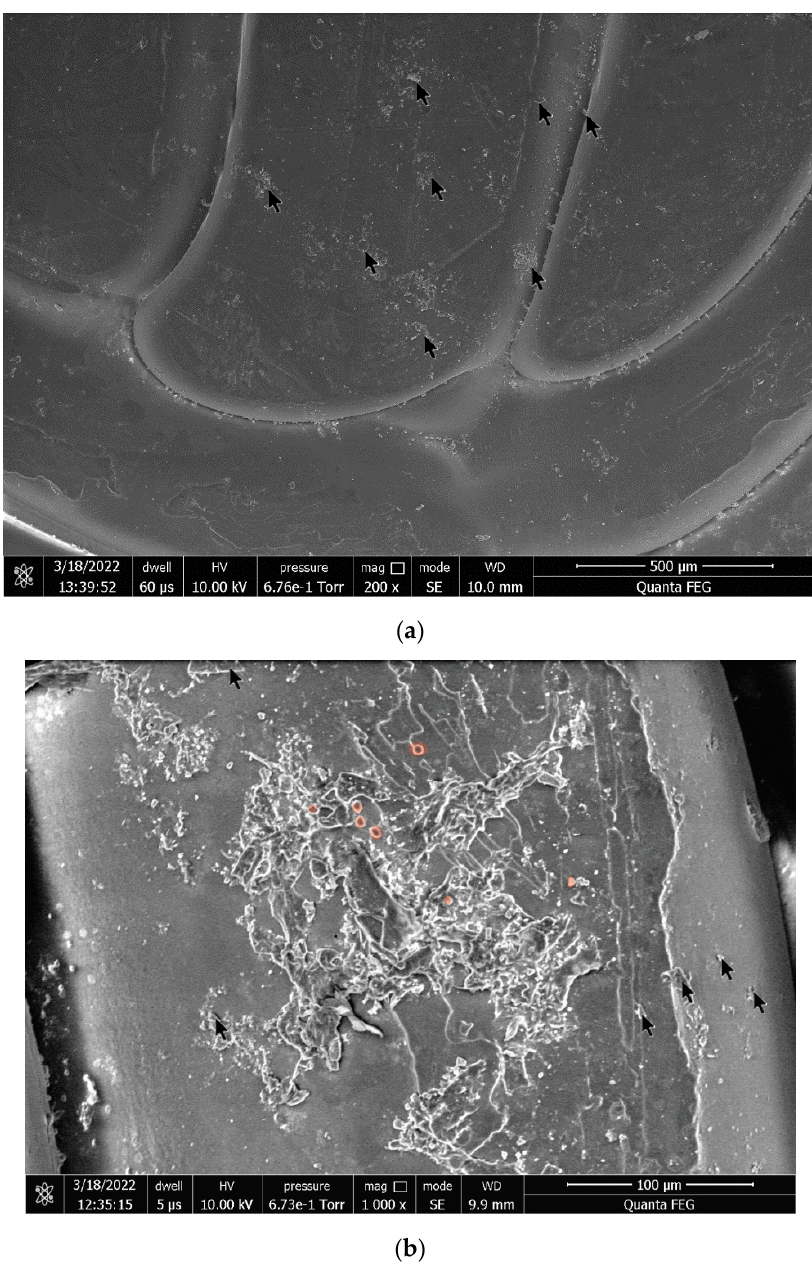
Figure 8. SEM photos of the cells on the surface of PEEK sample: ( a ) PEEK-04-02 (200 × magnifica- tion); ( b ) PEEK-04-02 (1000 × magnification). Black arrows show the salt crystals, red points show peritoneal cells.